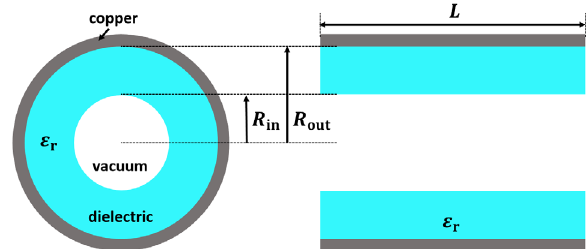
FIG. 2. Front view and longitudinal cross section of a cylin- drical DLA structure. ε constant, inner radius, outer radius, and length for the DLA structure.